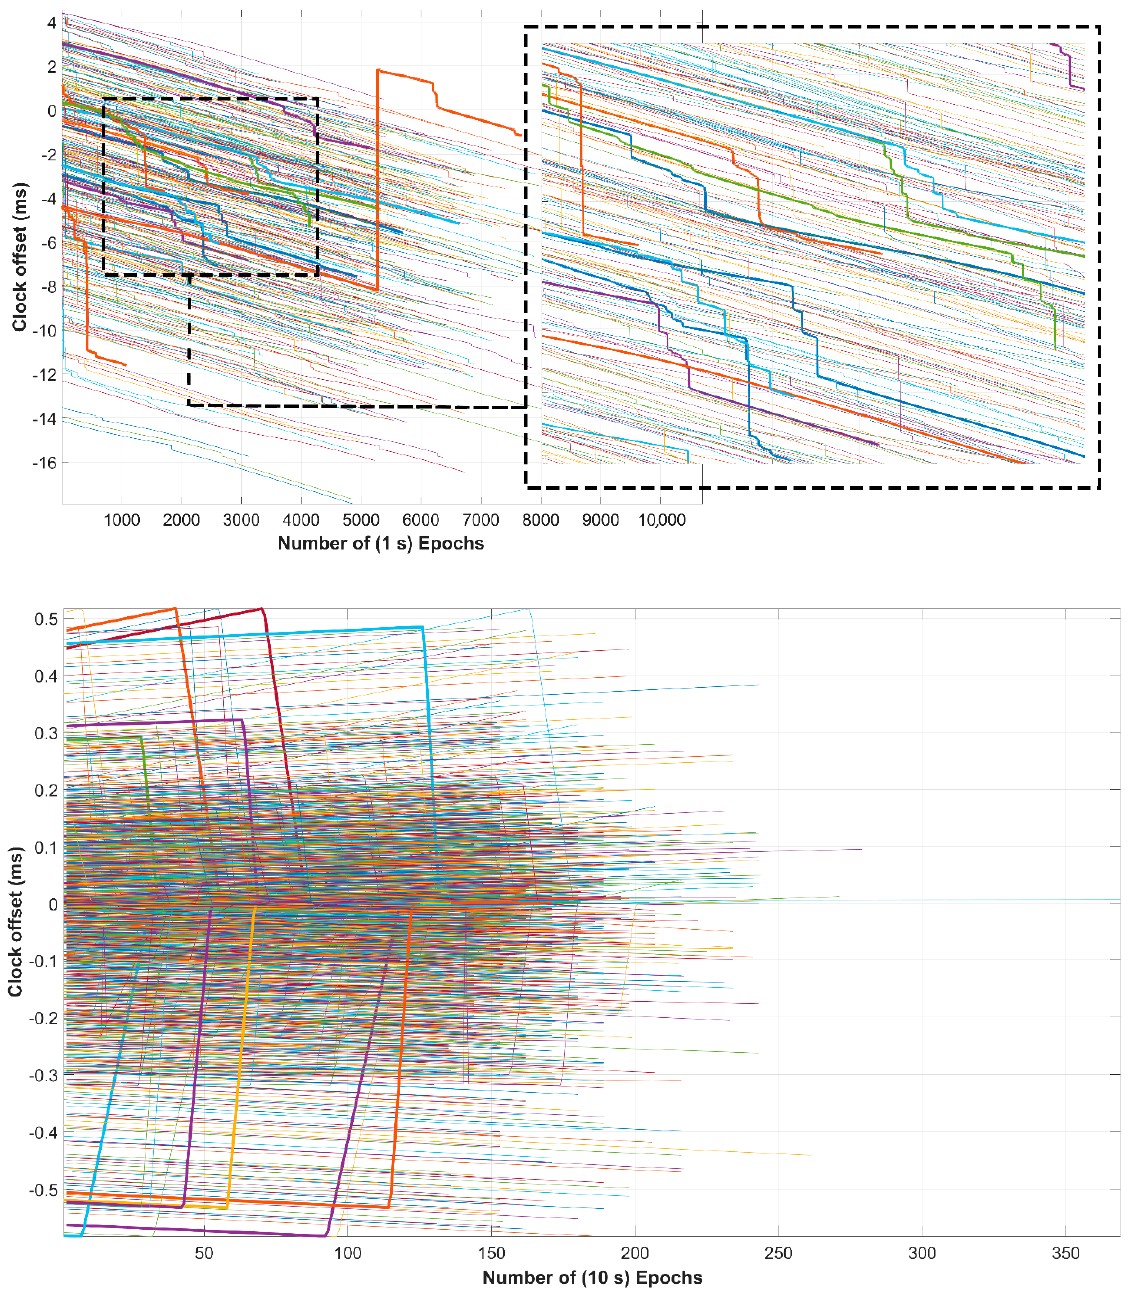
Figure 7. Estimated clock offsets from all observation segments of CubeSat 099 ( top ) and COSMIC-2A 1 ( bottom ) over the testing period. Several millisecond jumps are observed for CubeSat’s oscillator compared to the USO’s onboard COSMIC-2. Some of the clocks are plotted in bold for better visibility.